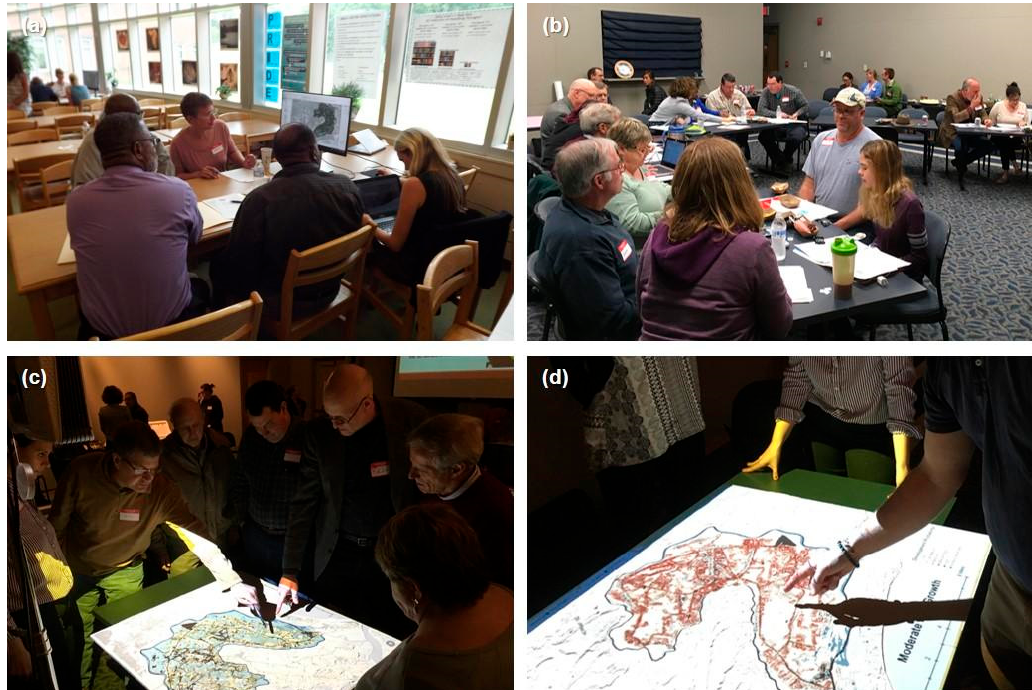
Figure 3. At stakeholder workshops, concerned residents of Johns Island, SC, ( a ) identified areas of the island that provide ecosystem services in a geographic information system (GIS); ( b ) ranked conservation priorities of these areas on paper maps; and ( c and d ) examined and provided feedback on the results of a geospatial land change model predicting locations of development over the next 50 years.